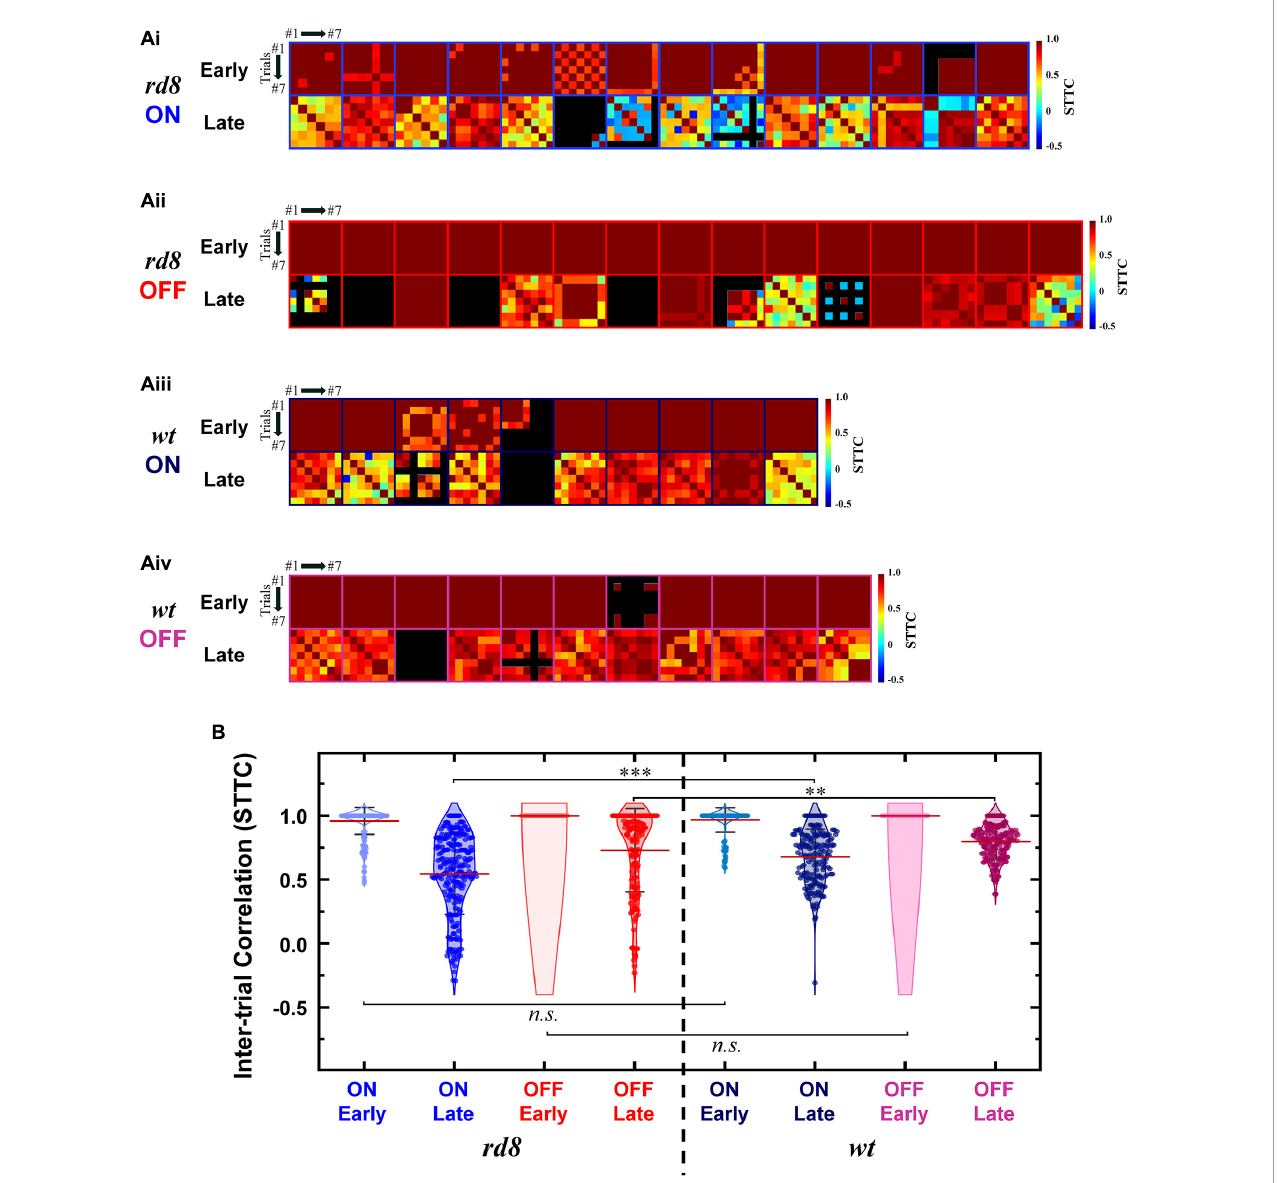
FIGURE7 Spike timing of late response becomes less consistent in both ON and OFF RGCs of rd8 than wild-type ( wt ) retinas. (Ai) Color-coded heatmaps of the spike time tiling coefficients (STTCs) of early and late responses for each ON RGC from the rd8 retinas. (Aii) Same as panel (Ai) but for OFF RGCs in the rd8 retinas. (Aiii,Aiv) Same as panels (Ai,Aii) but for the wt mouse retinas. An identical stimulus repeated typically for 7 times (at least 6 times). Black color in matrices indicates no response was elicited in those trials. (B) Violin plots of all STTCs computed from all rd8 and wt RGCs. Red horizontal line indicates average STTC value of each group. Four violin plots on the left side are from RGCs of the rd8 retinas and the other four violin plots on the right side are from the wt retinas. Statistical significance was assessed using the one-way ANOVA with Holm-Sidak post-hoc comparisons; ∗∗∗ p < 0.001, ∗∗ p < 0.01, and n.s. means not